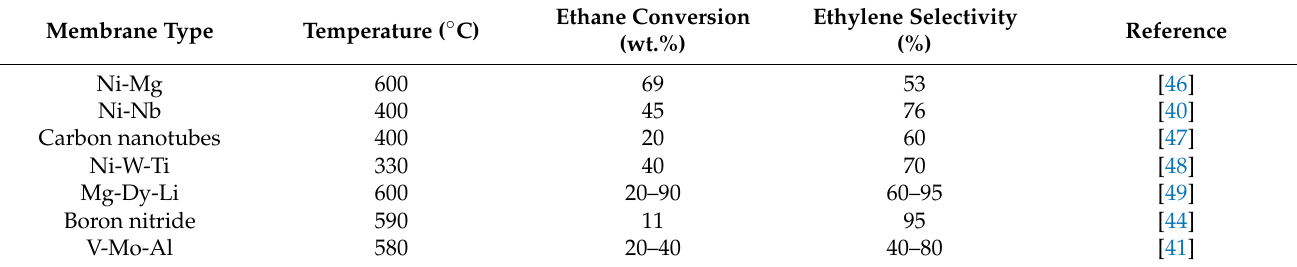
Table 3. Catalytic performance of the different membrane-based ethane ODH.